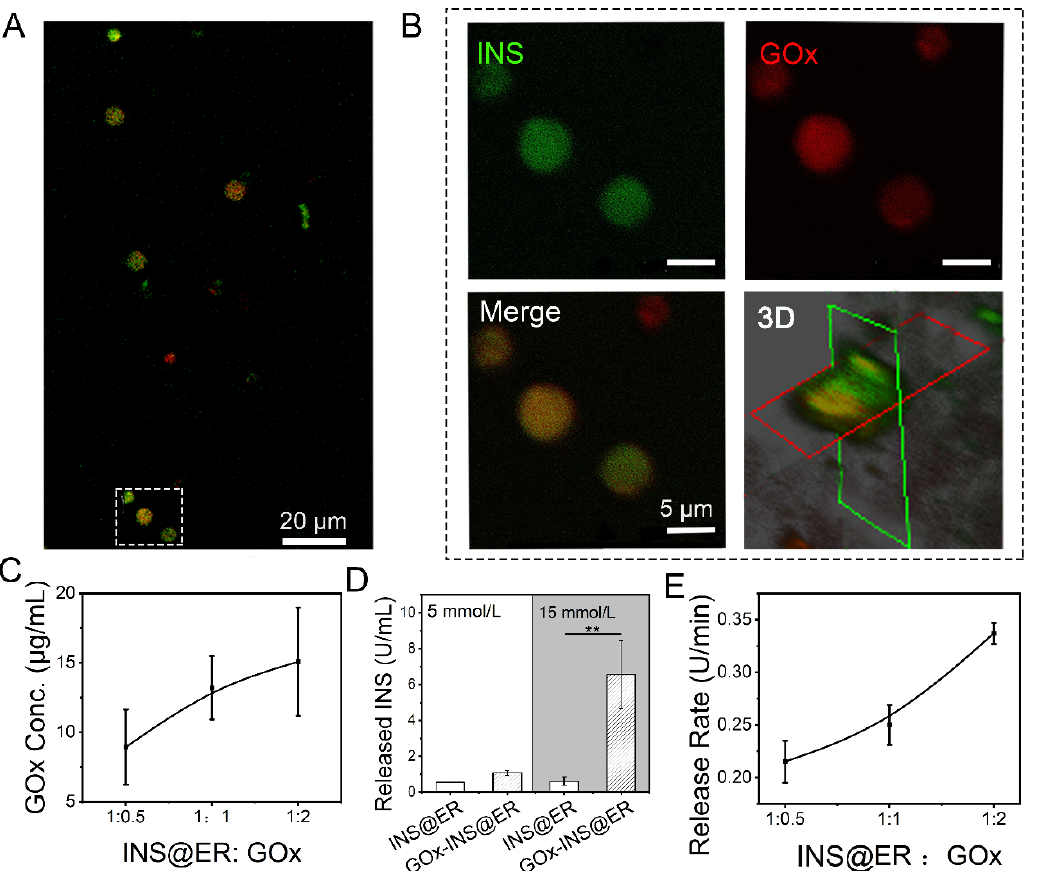
Figure 2. The construction of GOx-INS@ERs in the GOx reactor. ( A ) Confocal images of GOx- INS@ERs. Green: FITC-labeled INS; red: rhodamine-B-labeled biotin-GOx. ( B ) Zoom-in views of the white dotted boxed areas in Figure 2A and confocal microscopy 3D-reconstruction of GOx- INS@ERs. ( C ) The curvilinear relationship between ER and GOx ratio and the concentration (conc.) of GOx on the GOx-INS@ERs. ( D ) The INS release behavior of INS@ERs or GOx-INS@ERs in response to glucose; 5 mmol/L D-glucose: set as normal glucose level, 15 mmol/L D-glucose: set as hyperglycemic glucose level. ( E ) Relationship between different INS@ER to GOx ratios on